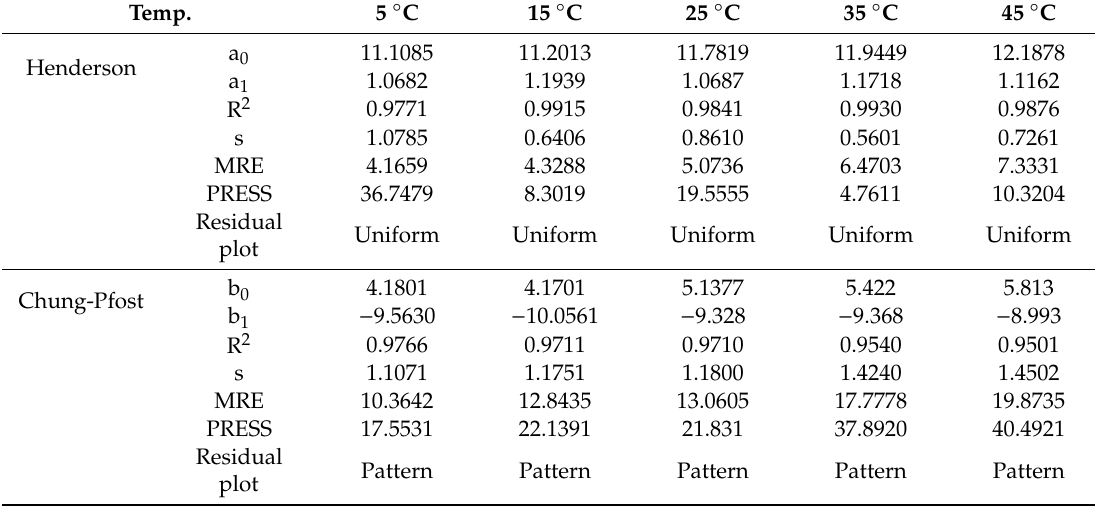
Table 4. Estimated parameters and evaluating criteria of six models used for adsorption data at five temperatures for A. formosanus Hayata.